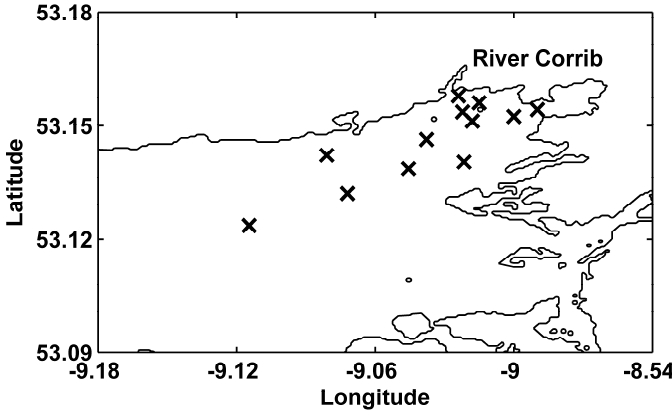
Figure 8. Map of upper northern half of inner Galway Bay, Ireland, (Figure 2) indicating the locations of the sample stations (x symbols) where both the CP885 and the ECOshot digital cameras were applied.